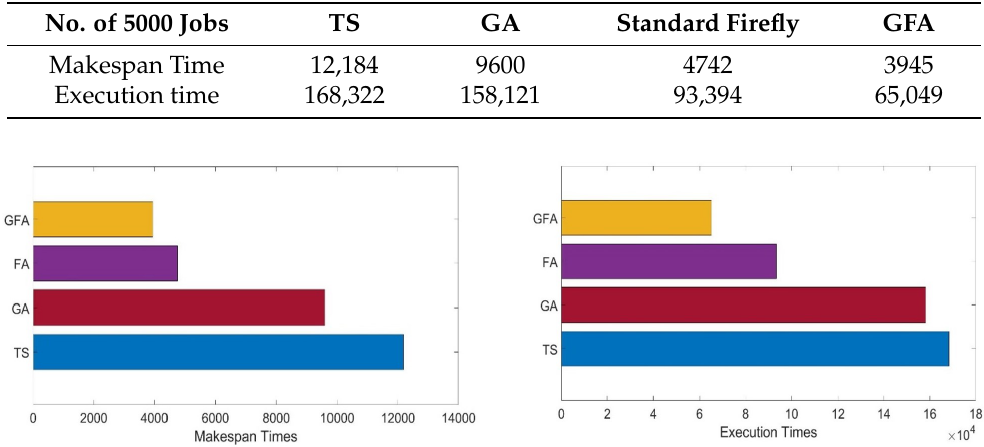
Figure 10. Makespan and Execution times for Heavy